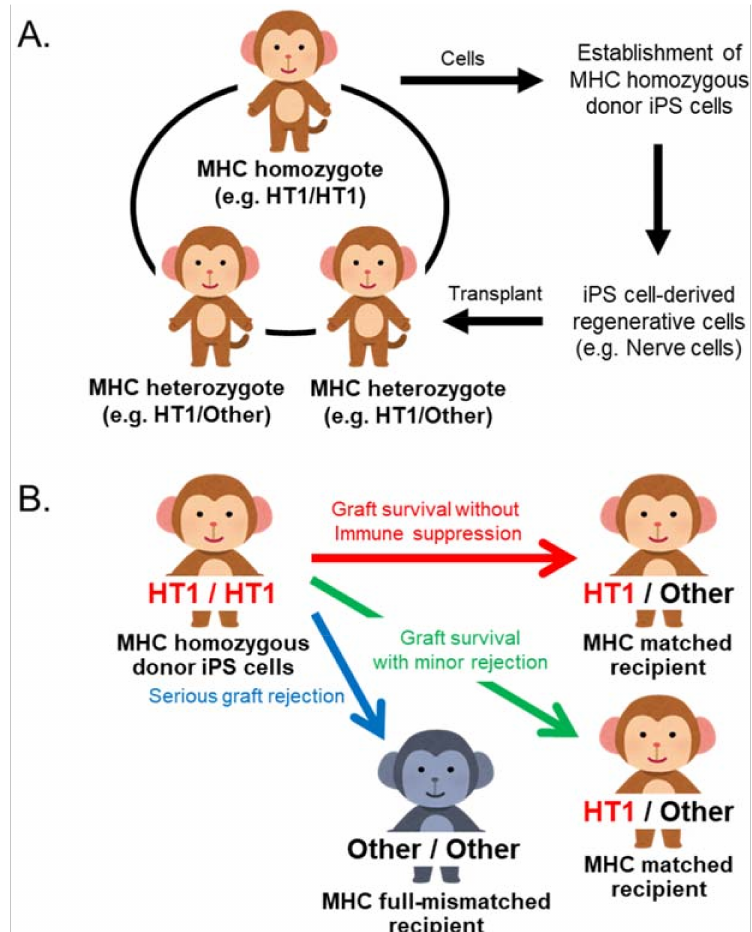
Figure 4. The iPS cell transplantation model and application for iPS cell transplantation study using MHC defined cynomolgus macaques. ( A ) This monkey model is used for analyses of engraftment rate of transplanted cells and inflammatory responses and used for evaluating safety and usefulness of iPS cell transplantation. ( B ) Summary of transplantation outcome between MHC matched recipient and mismatched recipient. MHC type mismatch in transplantation causes severe